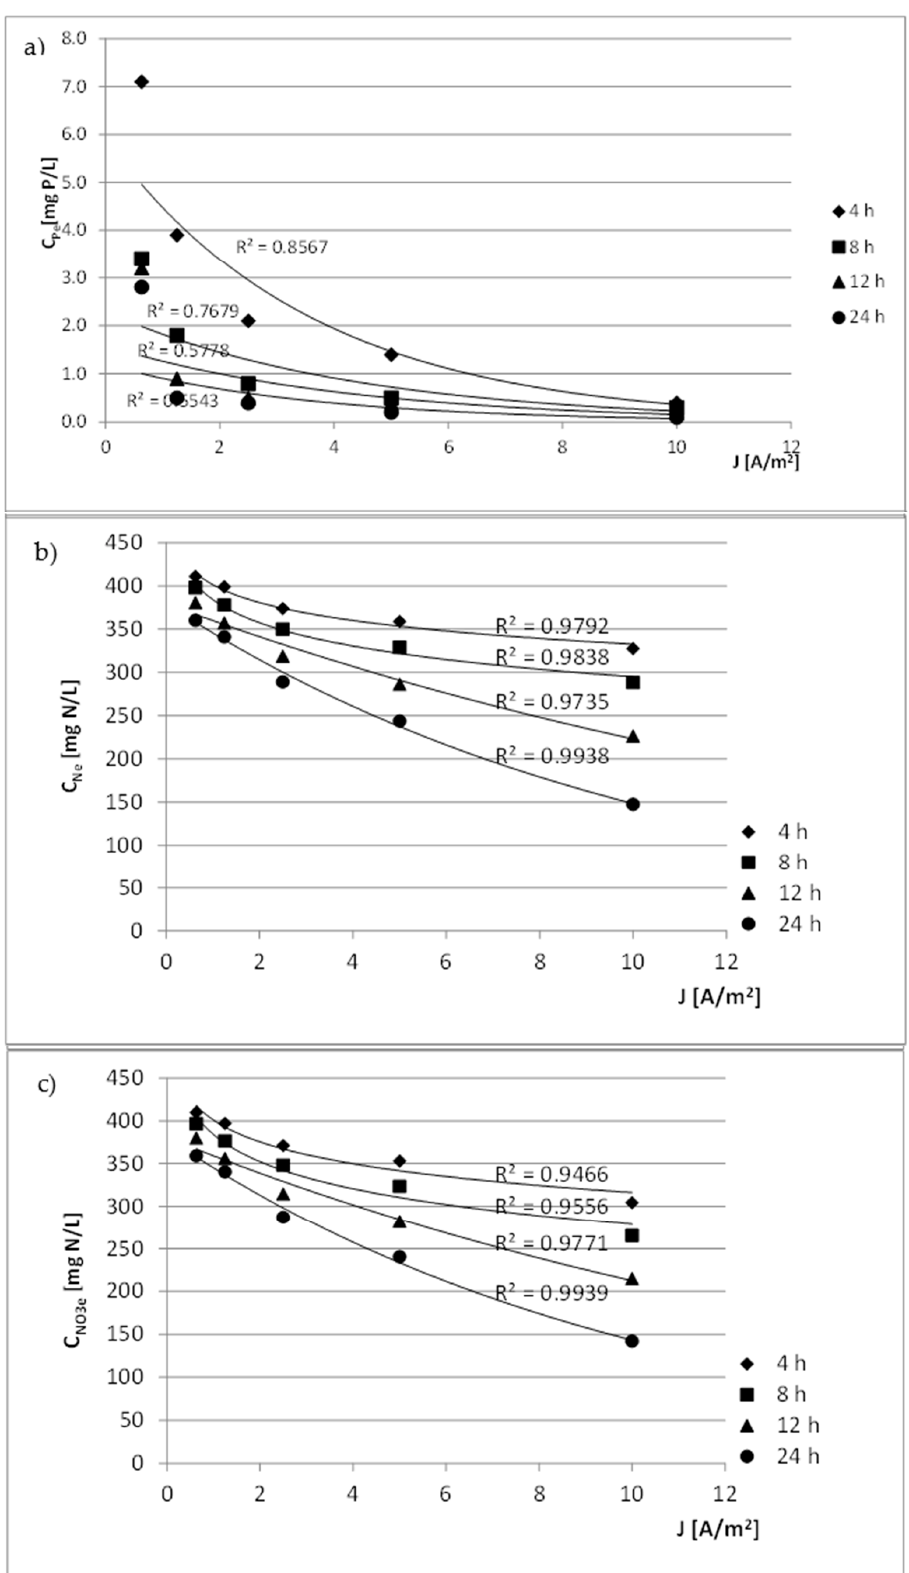
Figure 4. The influence of current density and HRT on the concentration of pollutants in the treated wastewater in the electrochemical rotating disc contactor (RECDC): ( a ) Phosphorus (C Pe ); ( b ) total nitrogen (C Ne ); ( c ) nitrates (C NO3e ).